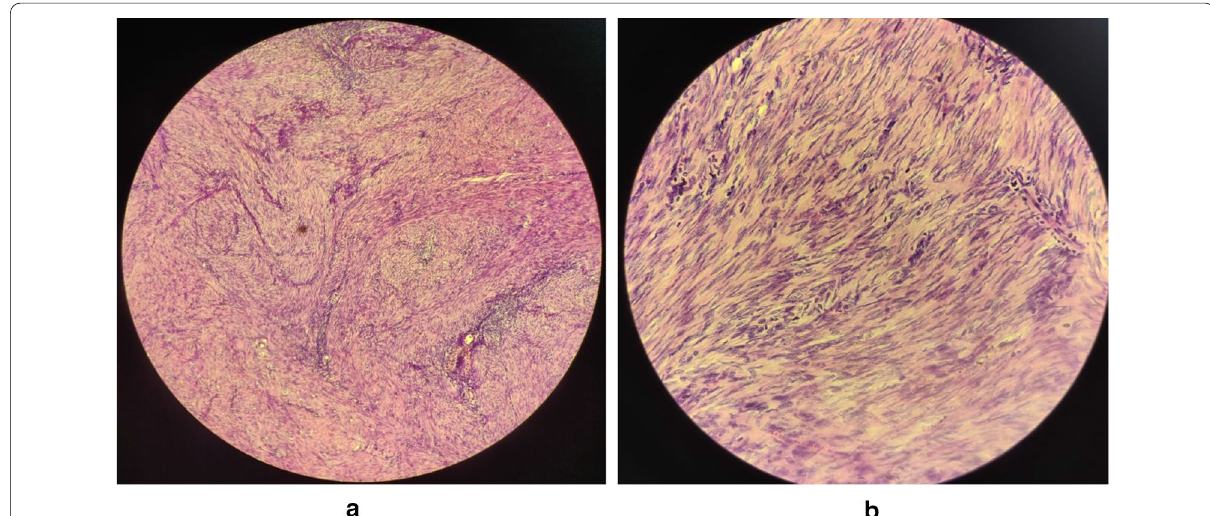
Fig. 3 Histopathology picture showing interlacing fascicles of spindle-shaped cells with oval nuclei and eosinophilic